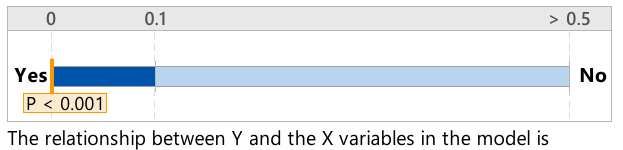
Figure 7. R 2 statistic with % of variation explained by the model.